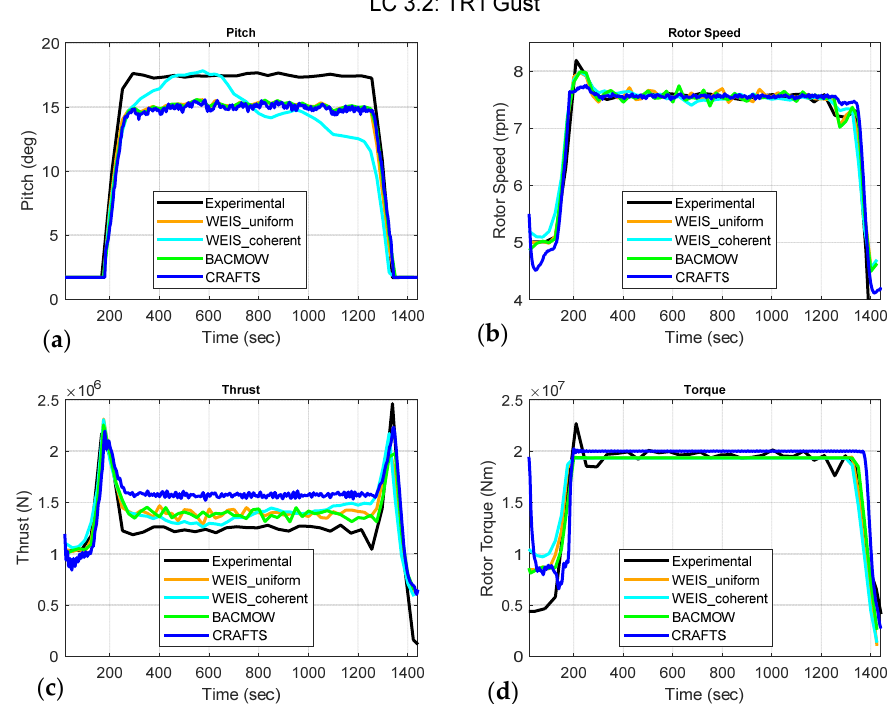
Figure 11. LC 3.2 metric calculation.